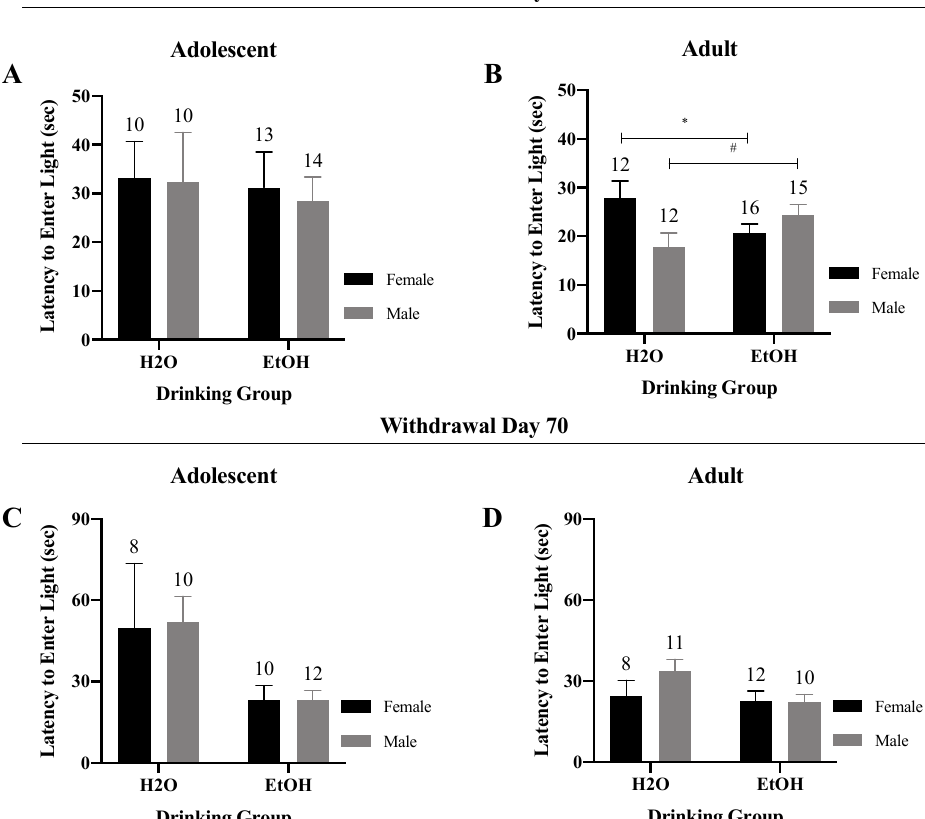
Figure 3. Summary of the results of the Sex × Drinking ANOVA conducted on the data for the latency to enter the light-side of the light–dark shuttle-box. ( A ) Depiction of the results for the adolescent-onset mice at 1-day withdrawal. ( B ) Depiction of the Sex × Drinking interaction observed for the adult-onset mice at 1-day withdrawal. ( C ) Depiction of the results for the adolescent-onset mice at 70-days withdrawal. ( D ) Depiction of the results for the adult-onset mice at 70-days withdrawal. The data represent the means ± SEMs for the numbers of mice indicated in each panel. * p < 0.05 for female H2O vs. female EtOH; # p < 0.05 for male H2) vs. male EtOH.